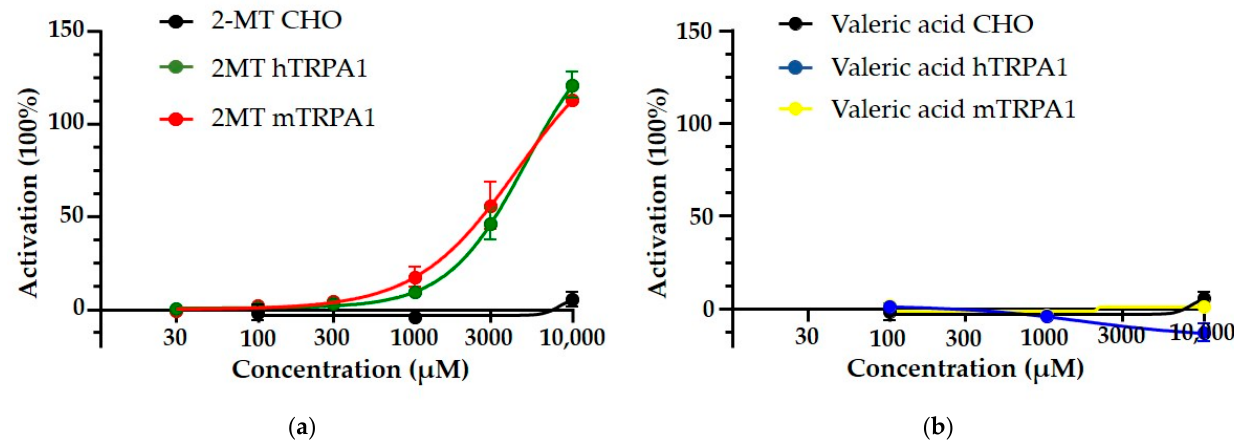
Figure 3. Effect of fox (2-MT) and cat odour (valeric acid) on the calcium response in Chinese Hamster Ovary (CHO) cells expressing human and mouse TRPA1 (hTRPA1 and mTRPA1, respectively) receptors. An increased calcium response was characterised by an enhanced ratio of Fluo-4 AM fluorescence compared to dye-loaded unstimulated cells. 2-MT resulted in a concentration-dependent elevation of the calcium response with an EC 50 value of 5010 µ mol/L in human TRPA1-expressing cells and with an EC 50 value of 4419 µ mol/L in mouse TRPA1-expressing cells ( a ). Applying valeric acid, neither human nor mouse TRPA1-expressing cell lines showed an elevated Ca 2+ signal ( b ). No change of the calcium response was detected in CHO cells not expressing TRPA1 in response to 100, 1000 and 10,000 µ mol/L 2-MT or valeric acid. n = 5–6 × 10 4 cells for all types of cell lines, all experiments were performed four times.